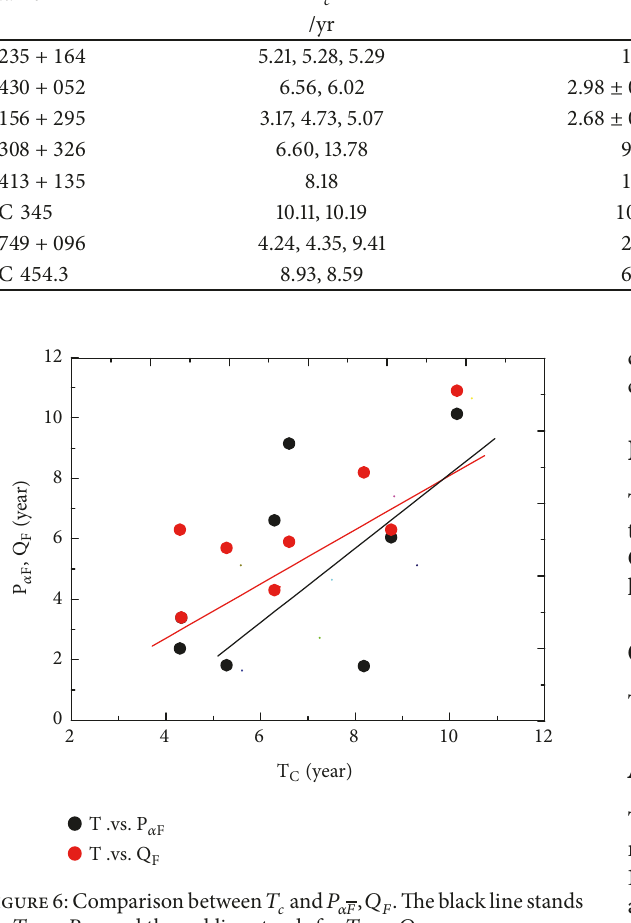
density variances. The 𝛼 − 𝐹 14.5 circles might come from the helical jet produced by the binary black